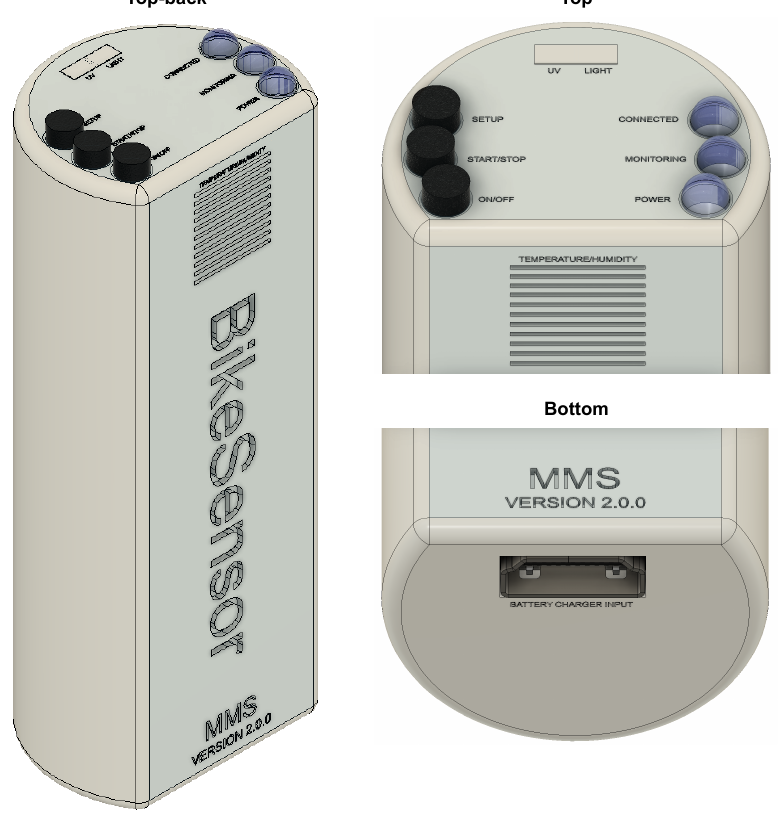
Figure 10. 3D model of the MMS version with the ability to collect data about air pollution, noise pollution, UV radiation, thermal sensation and luminosity.